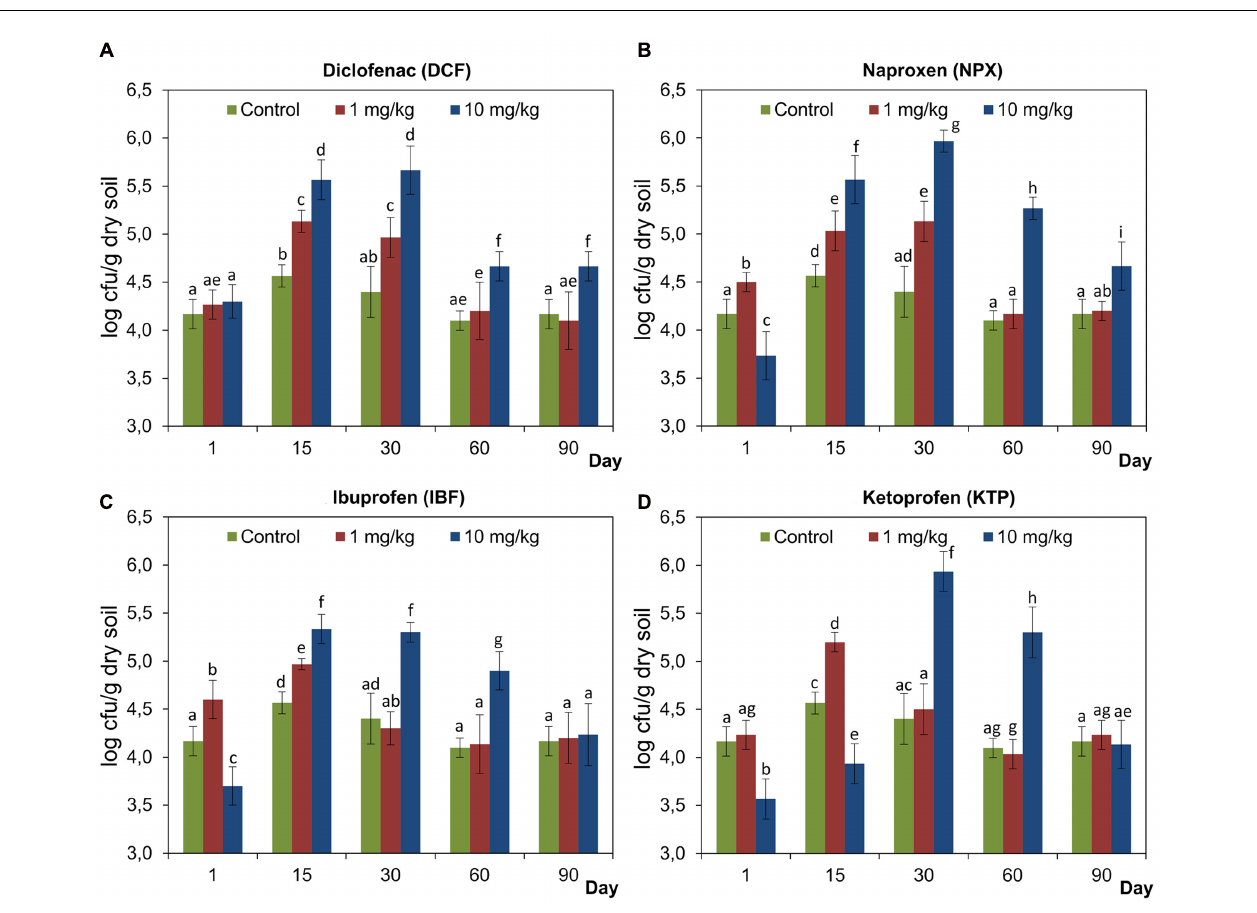
FIGURE 10 | The number of culturable fungi in control soil and soil treated with diclofenac (A) , naproxen (B) , ibuprofen (C) , and ketoprofen (D) at concentrations of 1 and 10 mg/kg soil during the 90-day experiment. The data presented are the means and standard deviations of three replicates and are expressed as log cfu/g dry soil. Different letters (within each drug) indicate significant differences ( P < 0.005, LSD test) related to the effects of concentration and